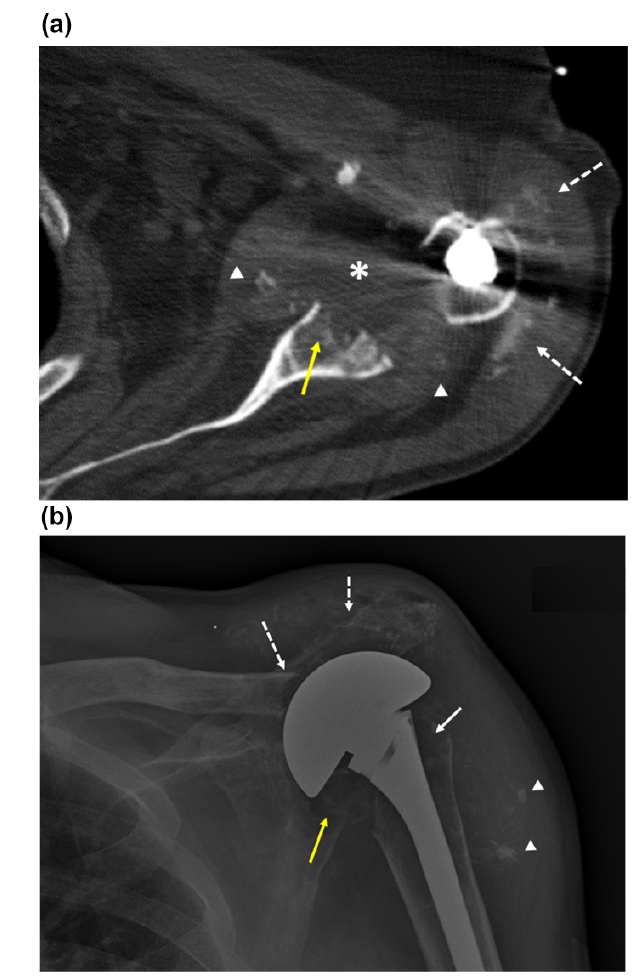
Figure 1. Imaging of the left shoulder before arthroplasty removal. (a) Axial CT image of the left shoulder demonstrating erosion of the anterior and central glenoid (solid yellow arrow) with heteroge- neously hypoattenuating material centered within the glenohumeral joint space, suggestive of complex effusion (*) and multiple intra- articular fragments of ossific debris (arrowheads) abutting the mar- gins of the thickened joint capsule. This appearance would be most suspicious for septic arthritis, though neoplasm with necrosis could have a similar appearance. Apparent linear and punctate calcifica- tion within the subacromial–subdeltoid bursa (dashed white arrows) would be most compatible with displaced articular debris and het- erotopic soft tissue ossification, chondroid neoplasm not excluded. Streak artifact from the arthroplasty humeral component limits as- sessment of fine detail. (b) Anteroposterior radiograph of the left shoulder demonstrating erosive changes and extensive demineral- ization of the left proximal humerus (solid white arrow) with left shoulder arthroplasty hardware in place. Osseous fragmentation and erosion at the acromioclavicular joint, with secondary acromioclav- icular joint separation (dashed white arrows), and ossific debris in the subacromial–subdeltoid bursa and/or soft tissue heterotopic os- sification (arrowheads). There is additionally erosion and fragmen- tation of the glenoid (yellow